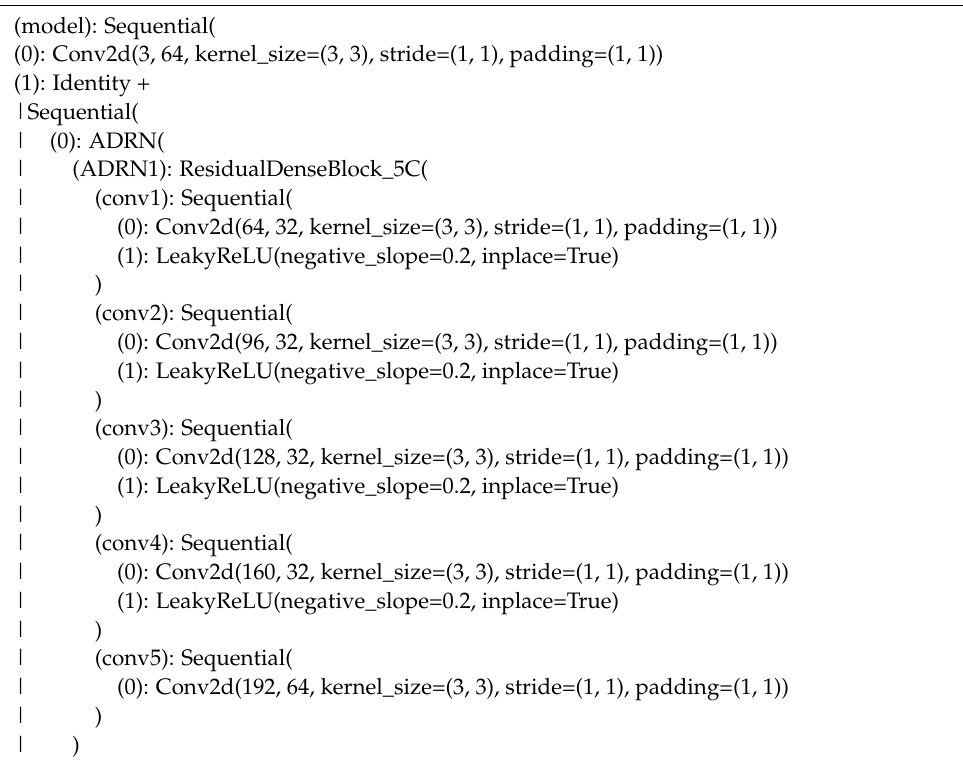
Algorithm 1 The PyTorch-like pseudocode of ADRN.